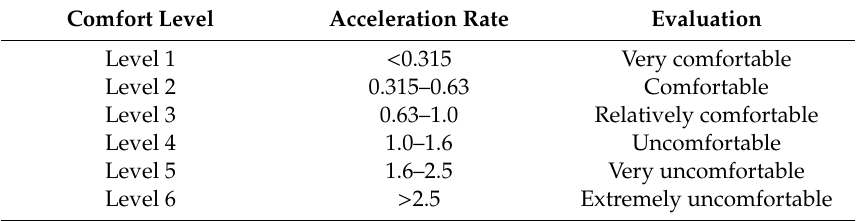
Table 2. International comfort